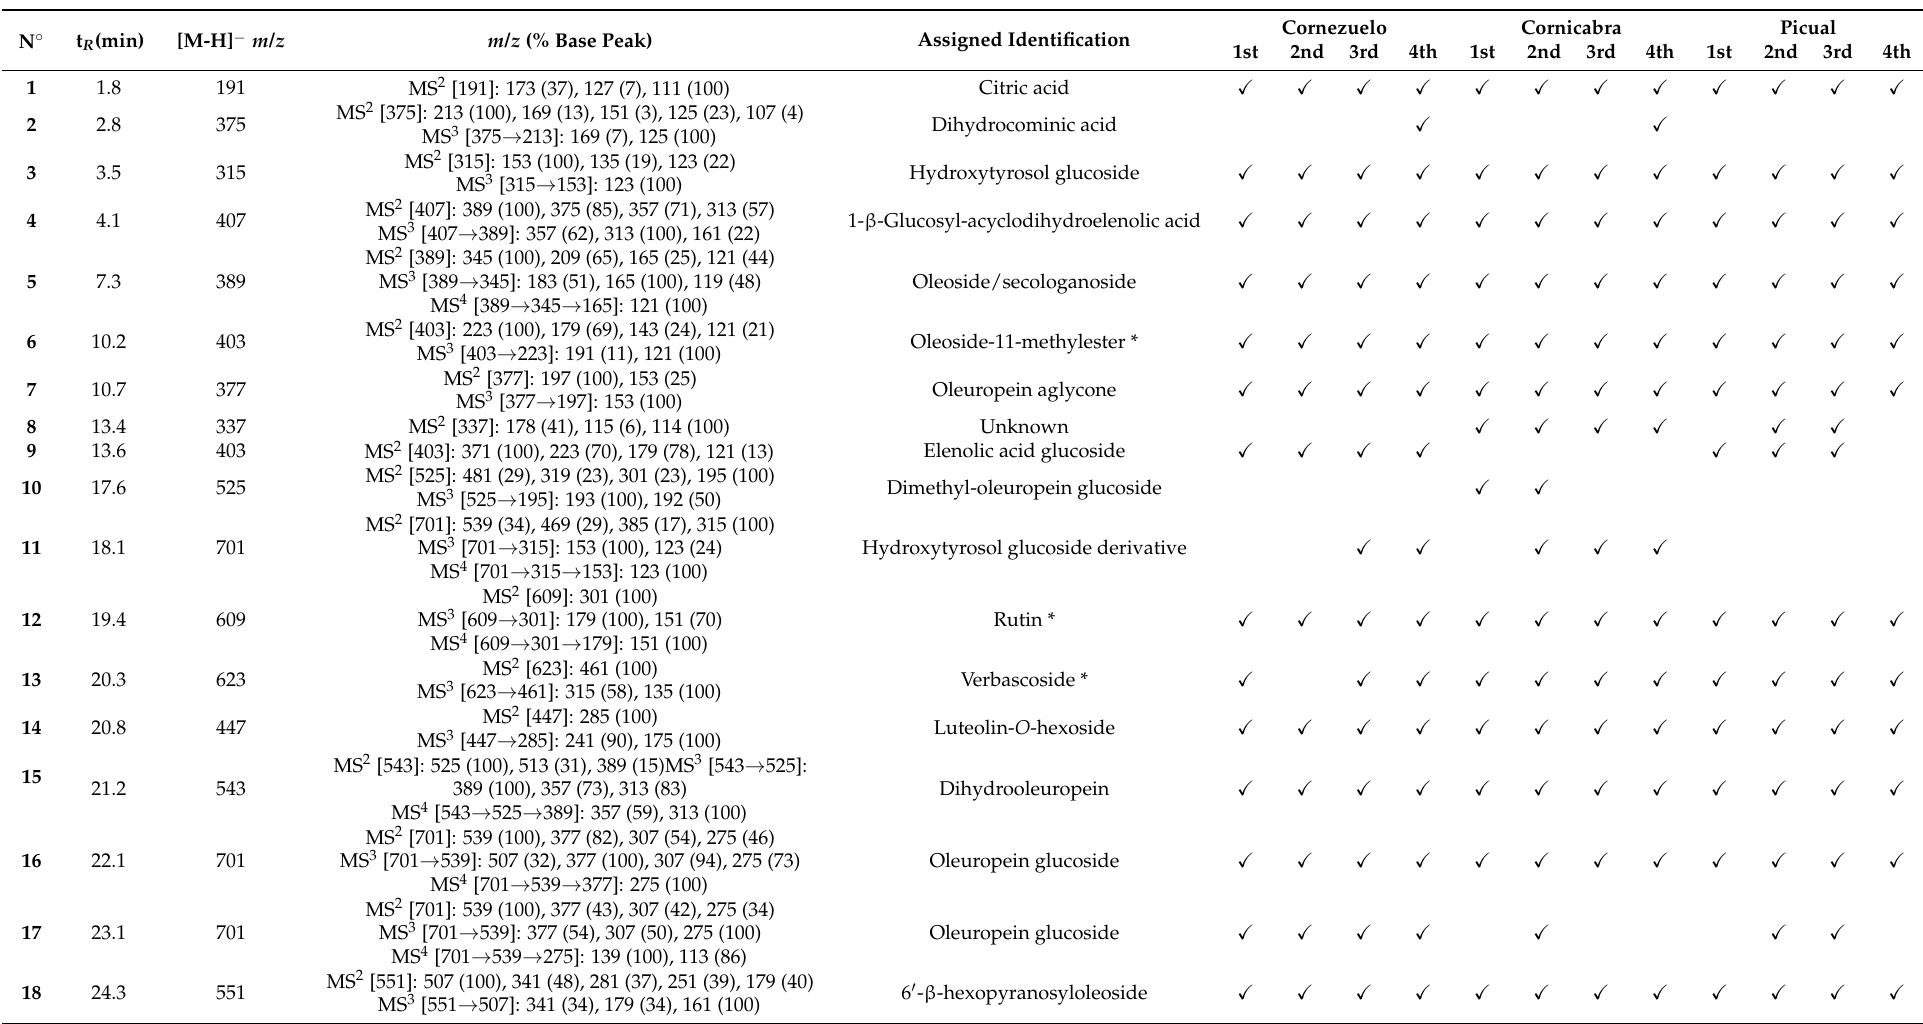
Table 1. HPLC–ESI–MS n characterization of phytochemicals in extracts of Cornezuelo, Cornicabra and Picual olive fruits in different months of season